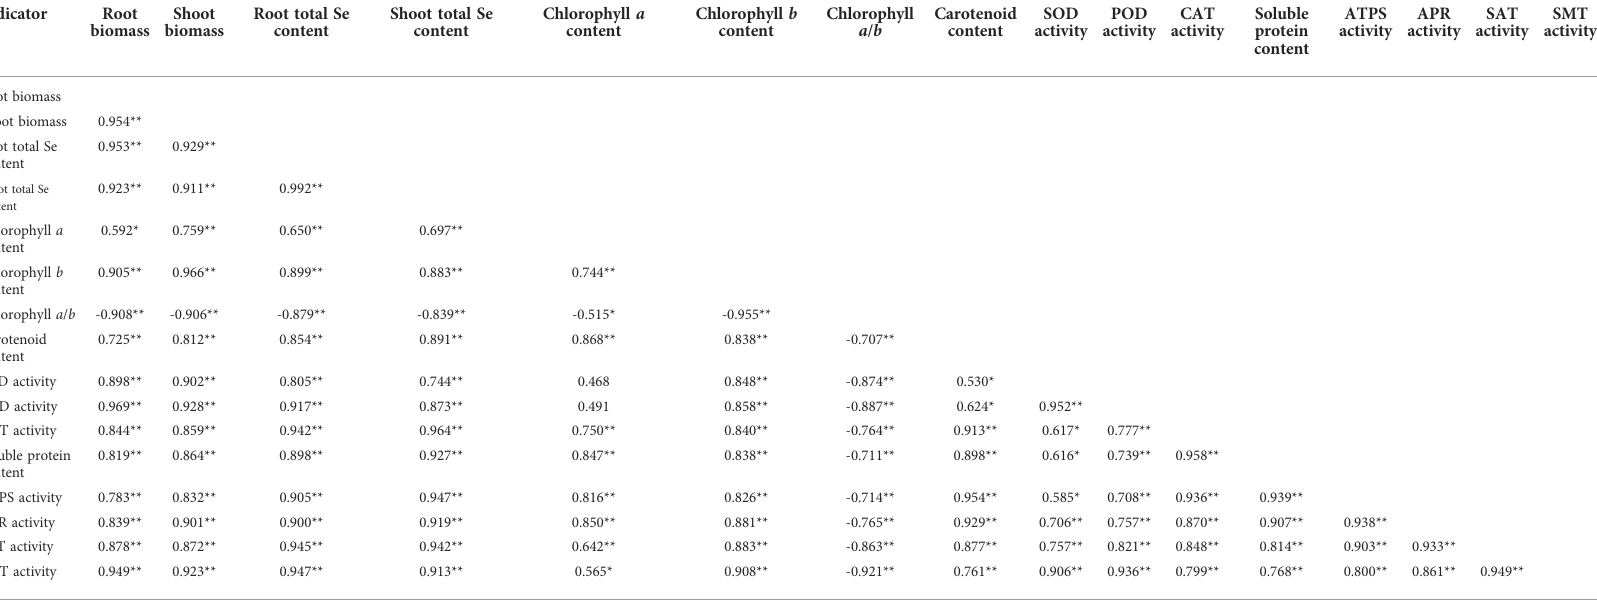
N = 15. **: Correlation is signi fi cant at the 0.01 level (2-tailed test). *: Correlation is signi fi cant at the 0.05 level (2-tailed